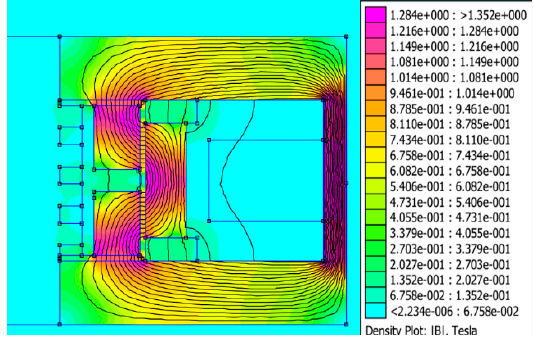
Figure 4. Magnetic field distribution of proposed model.